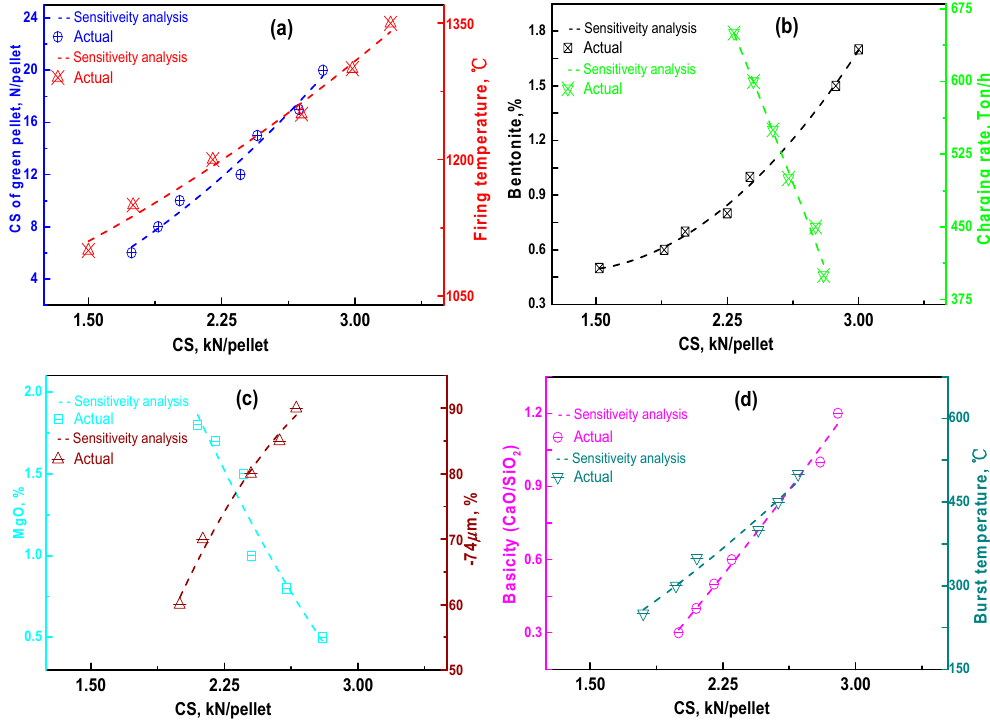
Figure 8. Sensitivity analysis of variables on CS. ( a ) CS of green pellet, firing temperature; ( b ) bentonite%, charging rate; ( c ) MgO%, particle size ( − 74 µ m%); ( d ) basicity, burst temperature. Figure 8a,b prove the following: (I) Increasing the bentonite dosage of green pellets can contribute to growth of the CS; the sensitivity analysis is also consistent with actual testing. This can be attributed